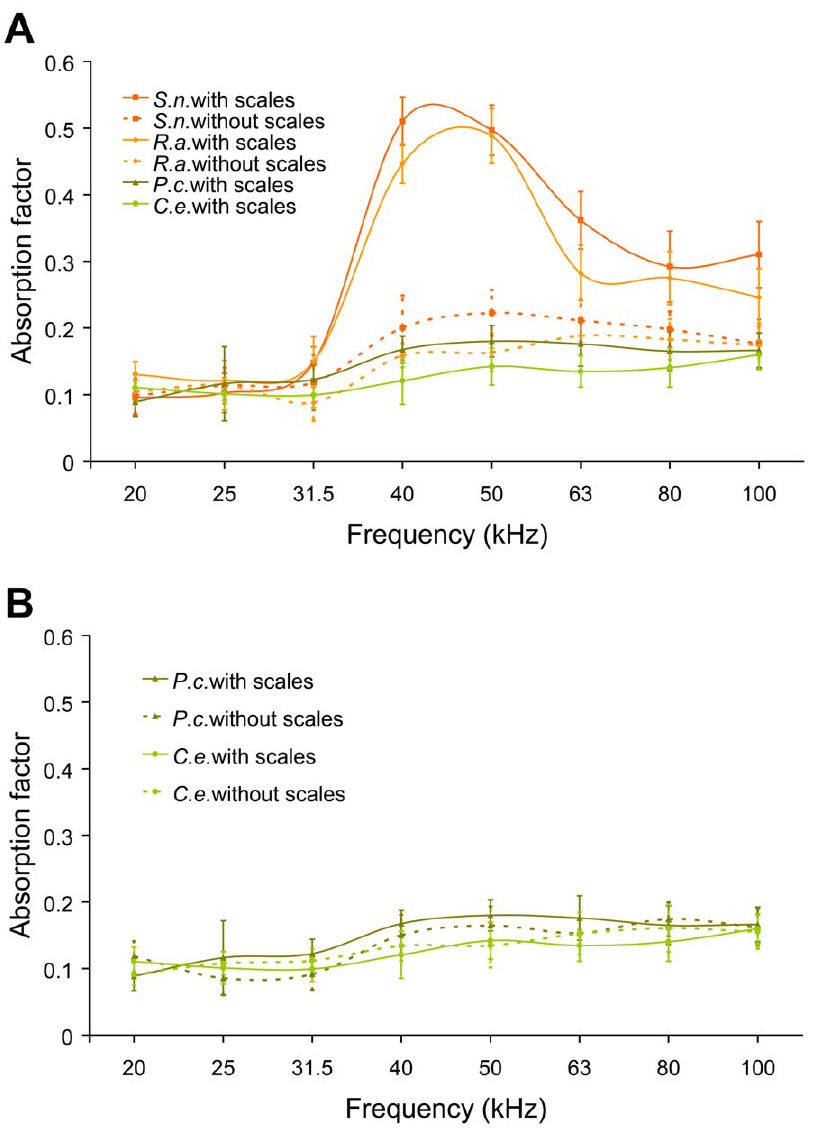
Figure 3. Absorption factor of wings with and without scales of moths and butterflies from 20 kHz to 100 kHz. Spilosoma niveus ( S.n. ), Rhyparioides amurensis ( R.a. ), Pieris canidia ( P.c. ) and Colias erate ( C.e. ). ( A ) Moths with scales differed significantly in absorption factors compared with moths without scales, and from butterflies with and without scales ( P , 0.001). Absorption factors of moths without scales did not differ from those of butterflies either with or without scales ( P , 0.05). ( B ) The absorption factors of butterfly wings with or without scales did not differ significantly ( P . 0.05). Experiments were performed in triplicate, and the SEM is indicated by the error bars, and n =15 for all samples.